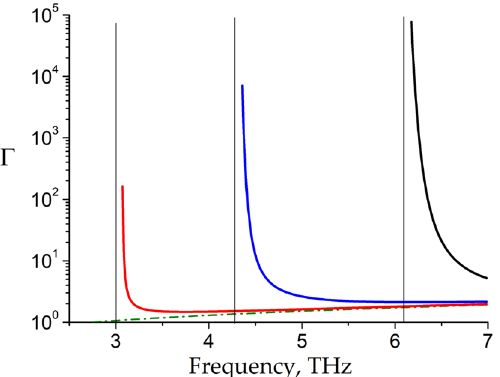
Figure 3. The power amplification factor Γ of the LSM plasmon in dependence on frequency for three different groove widths L = 0.5 μm, 1 μm, and 2 μm indicated by curves 1 , 2 , and 3 , respectively. The TM plasmon amplification factor is shown by dash-dotted curve 4 . Vertical straight thin lines indicate the cut-off frequencies of the LSM modes.